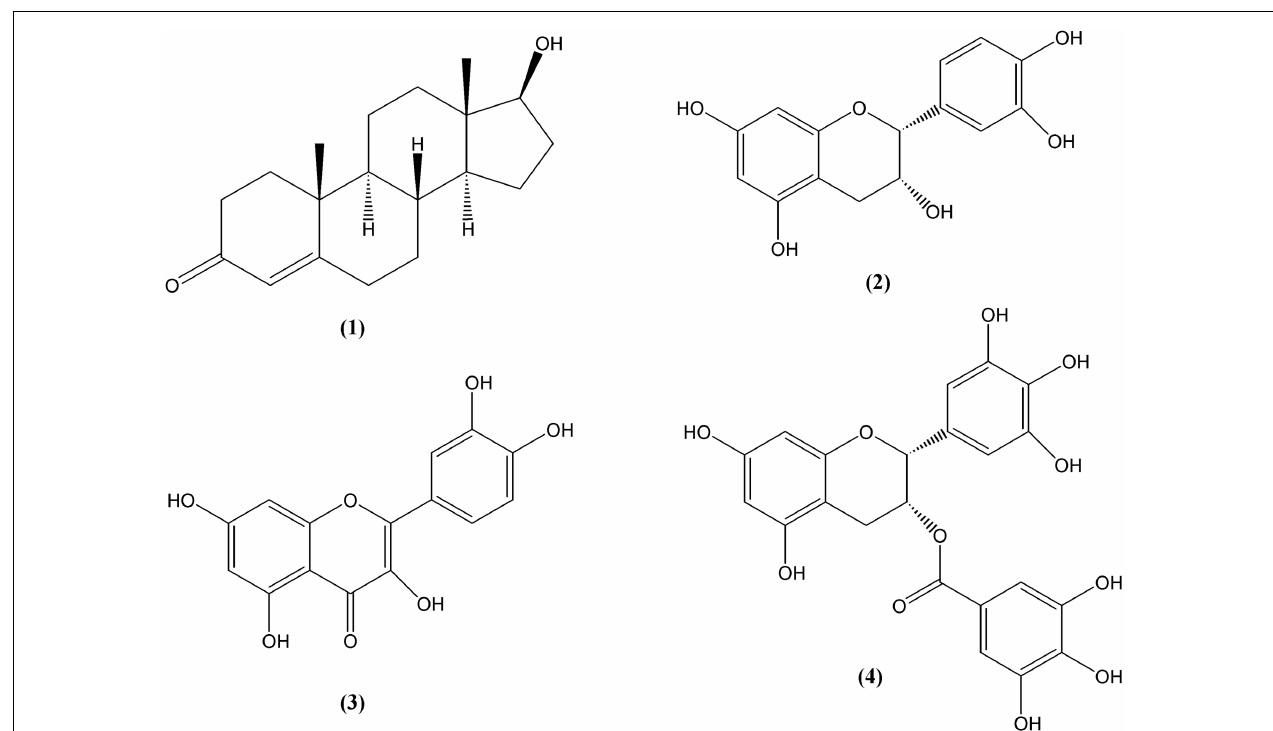
FIGURE 1 | Structures of testosterone (1) and selected inhibitors: epicatechin (2), quercetin (3), and epigallocatechin gallate (4)